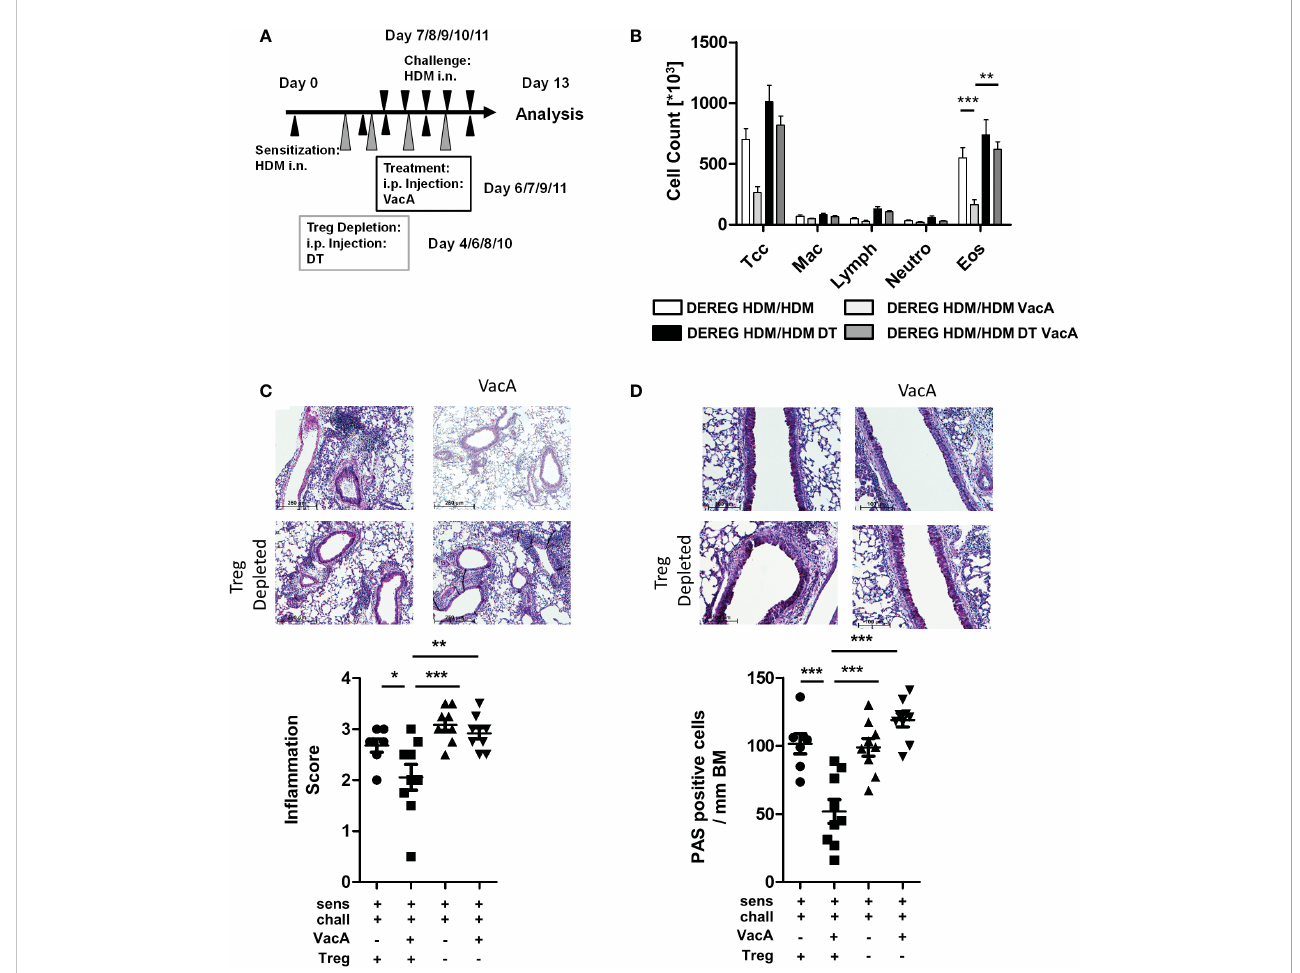
FIGURE 3 Depletion of Tregs in VacA-treated DEREG mice abolished therapeutic effects in the house dust mite (HDM)-speci fi c allergic lung disease model. (A) Tregs were depleted by repeated intraperitoneal administrations of diphtheria toxin (DT) on days 4, 6, 8 and 10. (B) Cellular composition of bronchoalveolar lavage (BAL): total cell count (Tcc), macrophages (Mac), lymphocytes (Lymph), neutrophils (Neutro) and eosinophils (Eos); DEREG HDM/ HDM (white), DEREG HDM/ HDM VacA (light gray), DEREG HDM/HDM DT (black) and DEREG HDM/HDM DT VacA (dark gray) mice. (C) In fl ammation in lung tissue: pictures show representative sections from each indicated group (x100). Scatter plot: in fl ammation score in DEREG HDM/HDM, DEREG HDM/HDM VacA and DEREG HDM/ HDM DT and DEREG HDM/HDM DT VacA mice. (D) Mucus-producing cells: pictures show representative sections from each group (x200). Scatter plot: number of mucus-producing cells/mm basement membrane in DEREG HDM/HDM, DEREG HDM/HDM VacA and DEREG HDM/HDM DT and DEREG HDM/ HDM DT VacA mice. Results from three independent experiments, n=5-9; Analysis of variance: *p<0.05, **p<0.01,